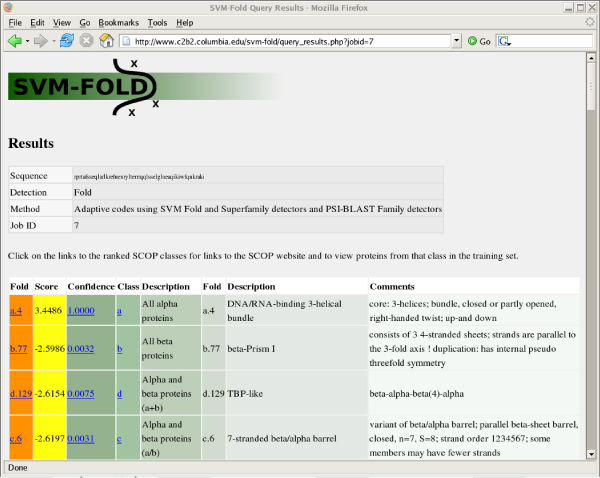
SVM-Fold results page. A screen capture of the